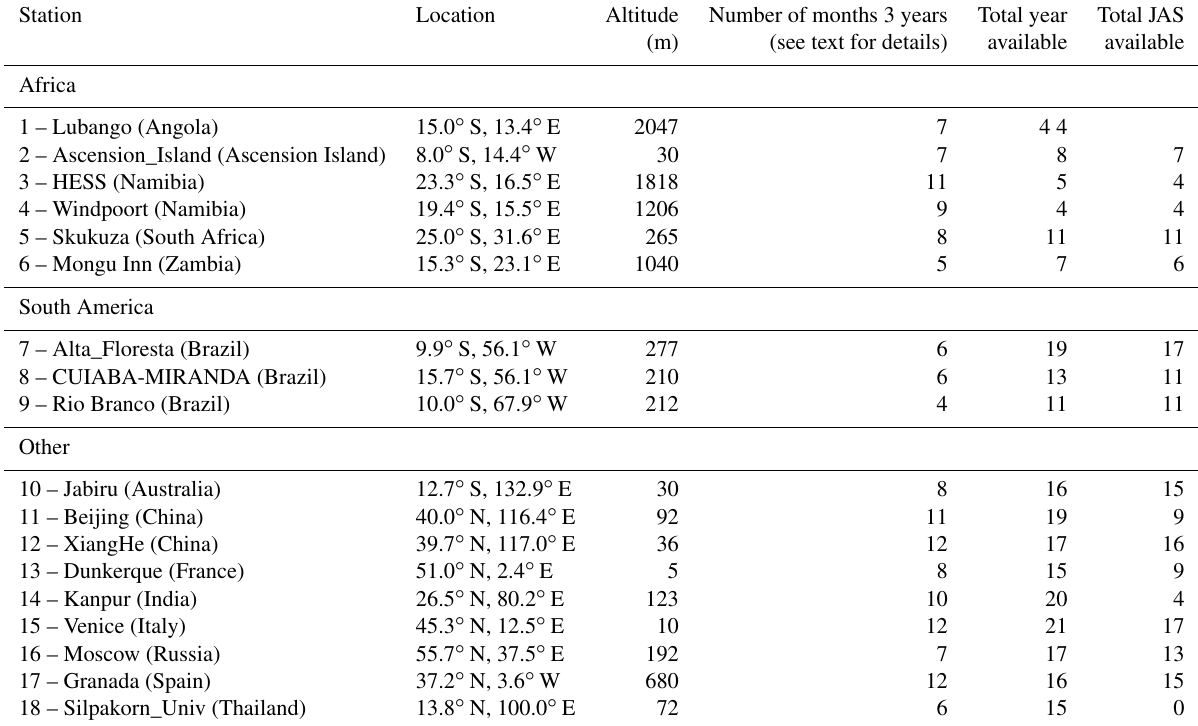
Table 1. Characteristics of the AERONET stations used in this study: station name, location, altitude, the number of months available over at least 3 years during the observation period (2000–2020), and the total year/JAS available over the observation period (2000–2020). Station